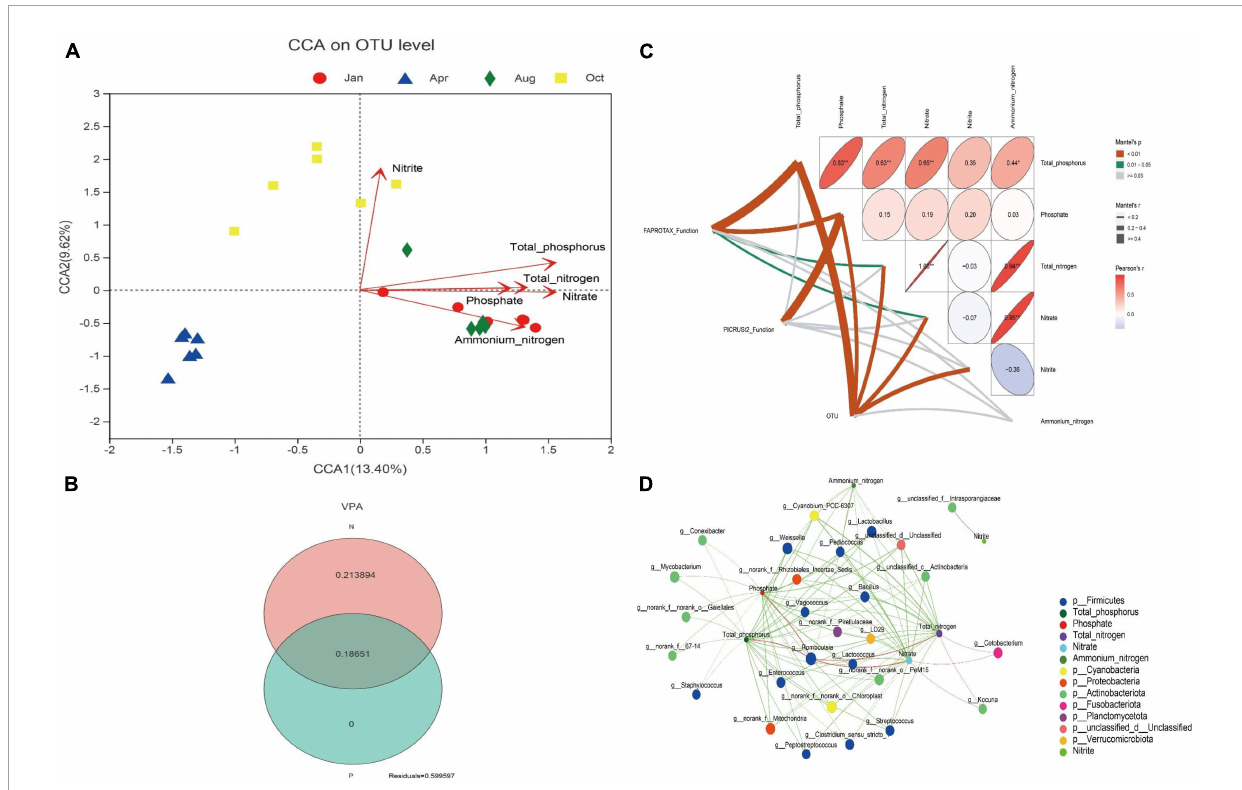
FIGURE4 Relationship between nitrogen and phosphorus with gut microbes. (A) Canonical correspondence analysis (CCA) plot for OUT level. Different colored dots in the figure represent different groups. Red arrows are corresponding environmental factors. The length of arrows can represent the relative influence of environmental factors on OTU data. (B) Variance partitioning analysis (VPA) venn diagram. N indicates the explanation degree of changes in gut microbiota composition by total nitrogen, nitrate, nitrite and ammonium nitrogen in water. P indicates the explanation degree of changes in gut microbiota composition by total phosphorus and phosphate. (C) Mantel test analysis plot. Matrices represent correlations between environmental factors. In the matrix, the direction of the ellipse represents positive or negative correlation. The color and value of the ellipse represent the pearson correlation coefficient. * p < 0.05, ** p < 0.01. The width of the line between FAPROTAX Function, PICRUSt2 function, and OUT to the environmental factor in the matrix represents the magnitude of their pearson correlation coefficient. The color of the line represents the significance of the correlation. (D) Network analysis plot. Pearson correlation coefficients were calculated between the top 50 bacterial genera in mean abundance and environmental factors. Nodes with absolute correlation coefficients greater than 0.5 and p < 0.05 were plotted. The circles in the figure represent different environmental agents or bacterial genera. The size of the circle represents the magnitude of the bacterial genus abundance or environmental factor values. Different colors represent different bacterial phyla or environmental agents. The color of the line indicates positive or negative correlation. Red indicates positive correlation, and green indicates negative correlation. The width of the line indicates the magnitude of the correlation